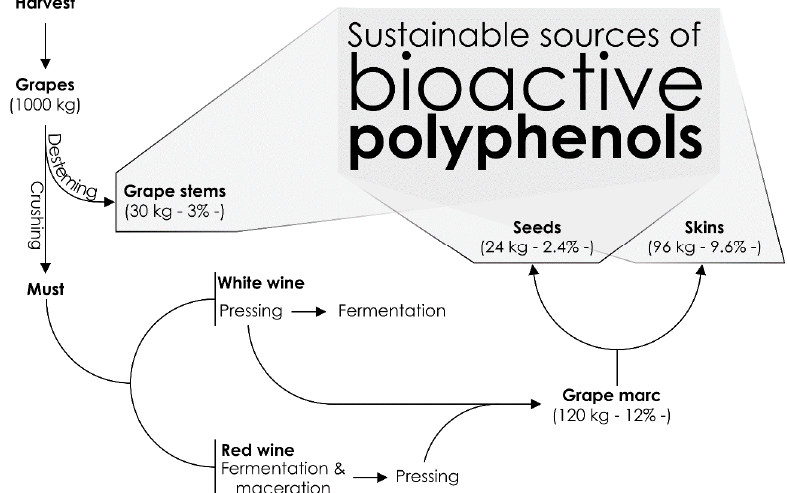
Figure 1. Flow diagram of vinification residues.